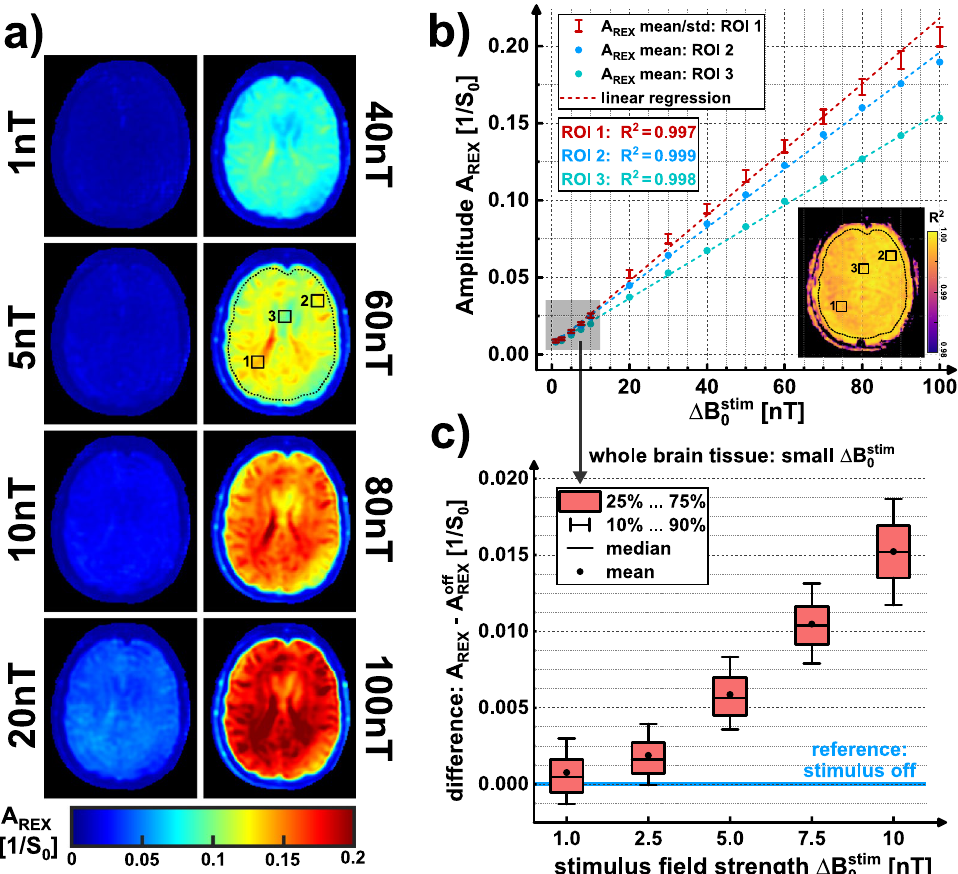
Figure 9. In vivo correlation measurements of the A REX amplitude and the stimulus field strength (cid:31) B stim 0 . The A REX values averaged within the marked ROIs for (cid:31) B stim 0 between 1 and 100 nT (14 steps) from the maps in ( a ) are plotted against field strength in subfigure ( b ). Linear regression yielded R 2 values > 0.99 for all three exemplary ROIs. The slope of the tREX calibration varies in different ROIs. The corresponding pixel-wise R 2 map of the linear fit is also shown in ( b ). The averaged R 2 in the whole brain tissue ROI (dashed line) was 0.9977 ± 0.0094. Due to the high agreement with the linear fit, tREX experiments enable in vivo calibration of REX amplitudes. This fact can be exploited in a fMRI experiment for quantifying neuronal magnetic